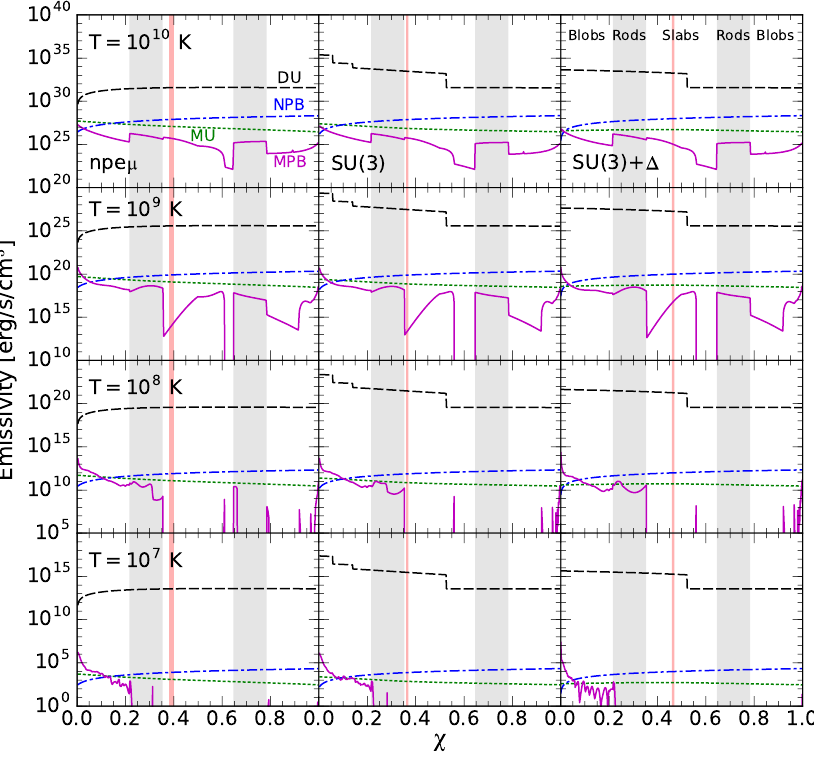
Figure 6. Neutrino emissivity in the quark–hadron mixed phase for the DD2 parametrization with G V = 0 [7]. Contributions due to mixed phase Bremsstrahlung (MPB), nucleon–nucleon and quark–quark neutrino pair Bremsstrahlung (NPB), the nucleon and quark modified Urca processes (MU), and the hyperon and quark direct Urca (DU) processes are included. See Figure 2 for additional details. Similar figures for the SWL, GM1L, and ME2 parametrizations can be found in